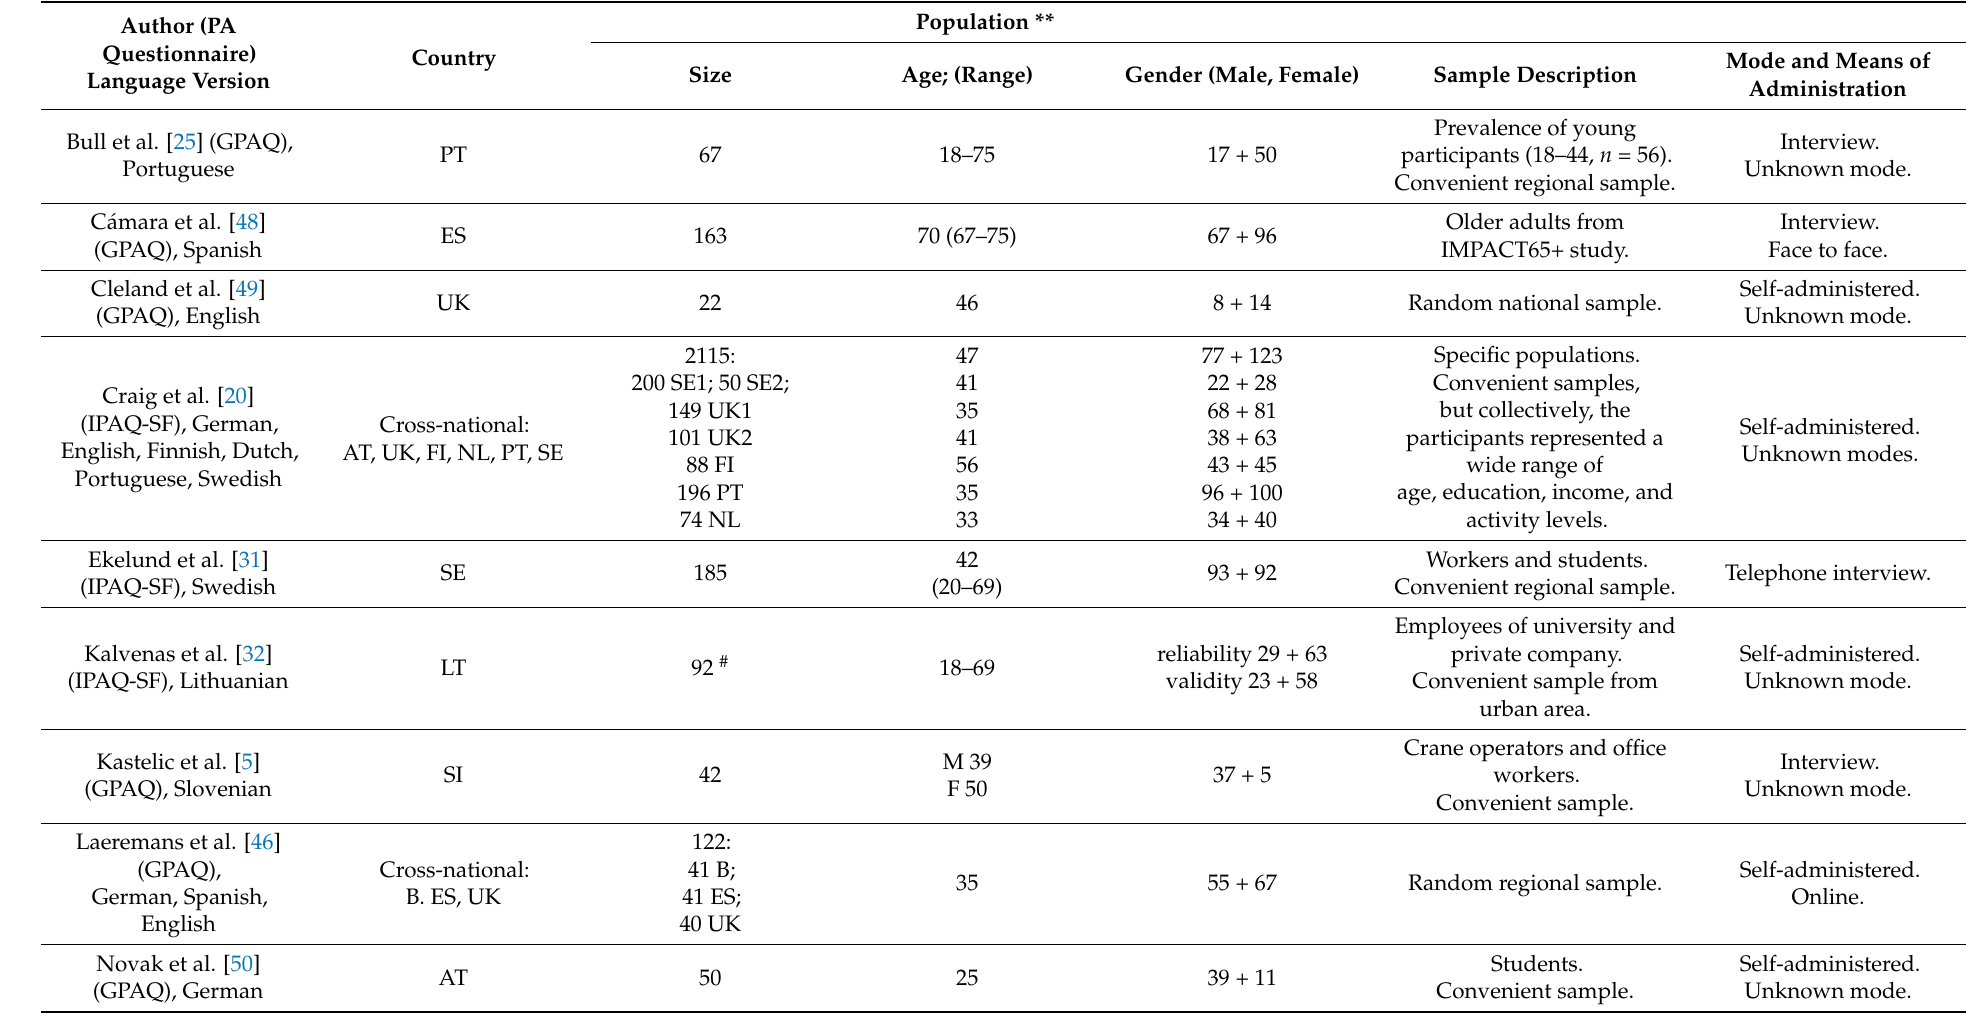
Table 2. General characteristics of selected studies assessing